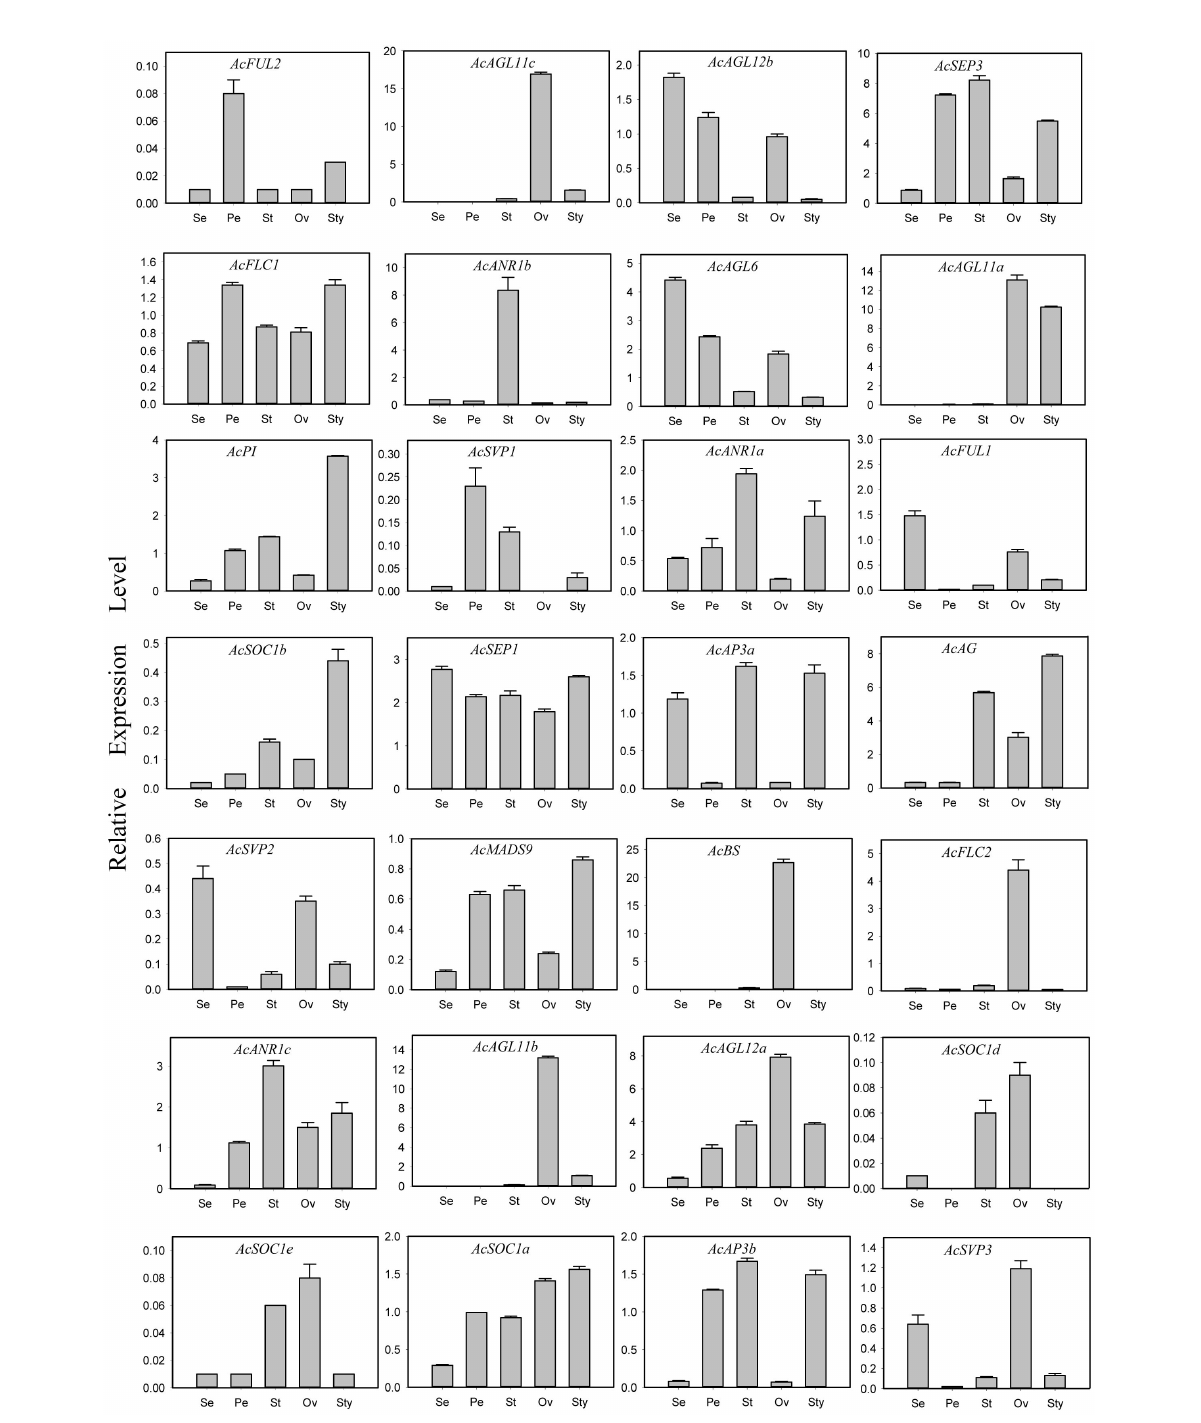
FIGURE 8 Expression patterns of 28 type II AcMADS genes in pineapple fl oral organs by qRT-PCR. The error bars represent the standard deviations of three biological replicates. Se: Sepal, Pe: Petals, St: Stamen, Ov: ovary, and Sty: